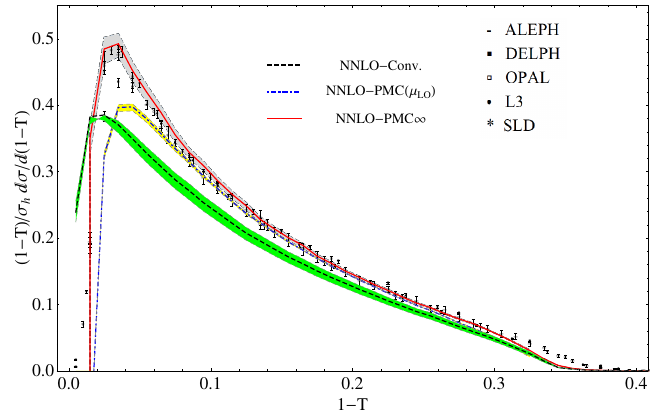
Figure 2: The thrust distribution at NNLO under the Conventional (Dashed Black), the PMC( µ ) (DotDashed Blue) and the PMC ∞ (Solid Red). The experimental data LO points are taken from the ALEPH, DELPHI,OPAL, L3, SLD experiments [ 34–38 ] . The shaded areas show theoretical errors predictions at NNLO (Ref. [ 13 ] .)